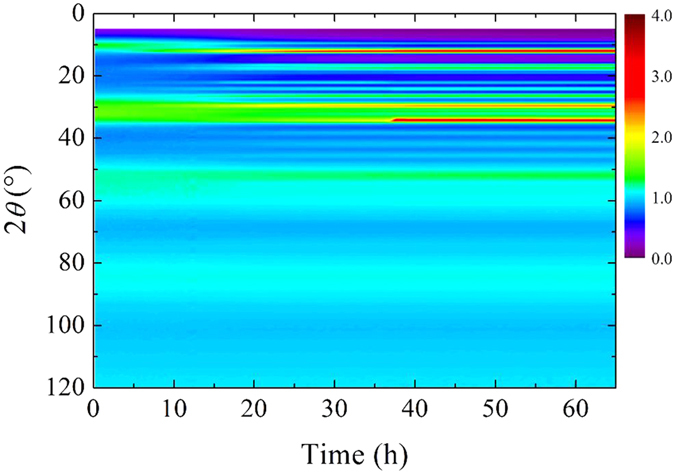
Time evolution of the static structure factor of GeO2 at Texp = 1100 K.Time increases from left to right. The color map shows the emergence of the crystalline pattern.